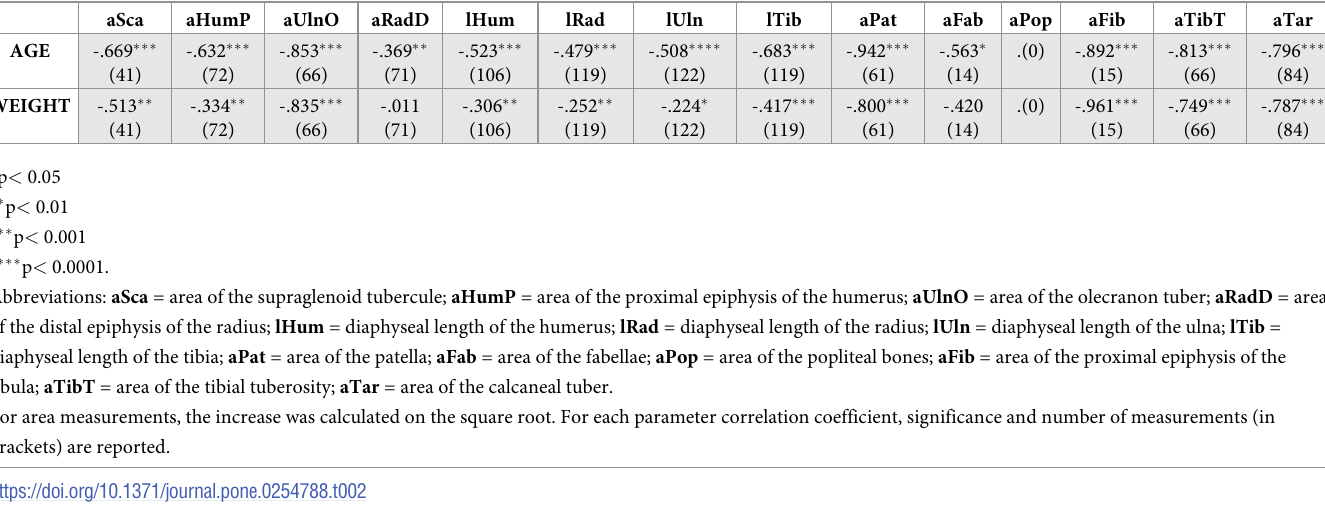
Table 2. Spearman’s rank correlation between the relative increase in the radiographic measurements and age and body weight. aSca aHumP